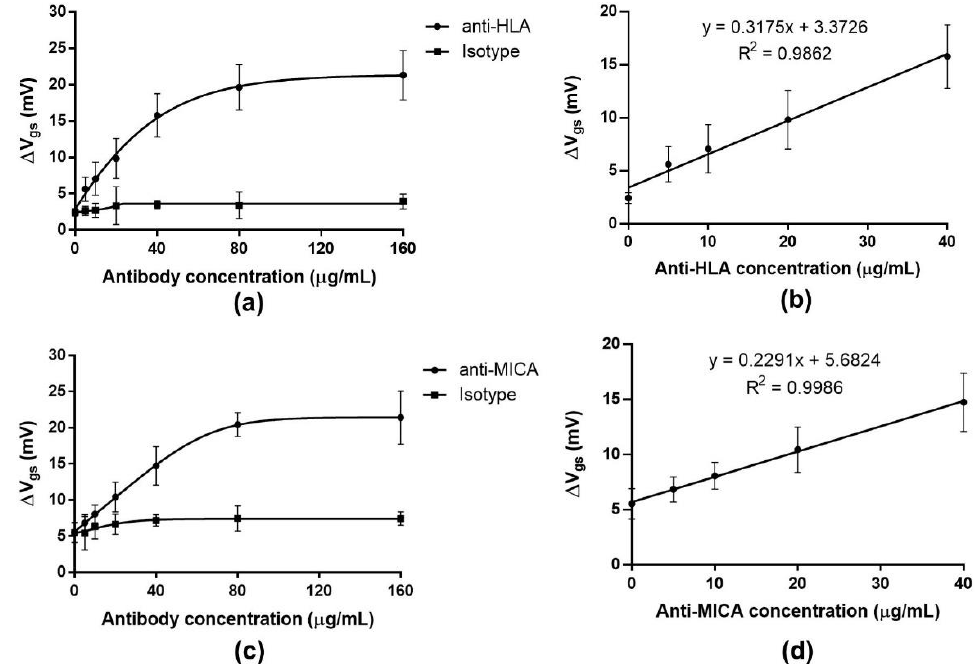
Figure 9. Dose-response curve exhibits the gate potential changes against different concentrate ions of antibodies. ( a , c ) represent the dose-response curve obtained from the anti-HLA and -MICA, respectively. ( b , d ) represent the linearity range and the slope of the dose-response curve obtained from HLA and MICA antibodies, respectively. Each dataset shows the mean and SD of the ΔV gs calculated from three different ISFETs.